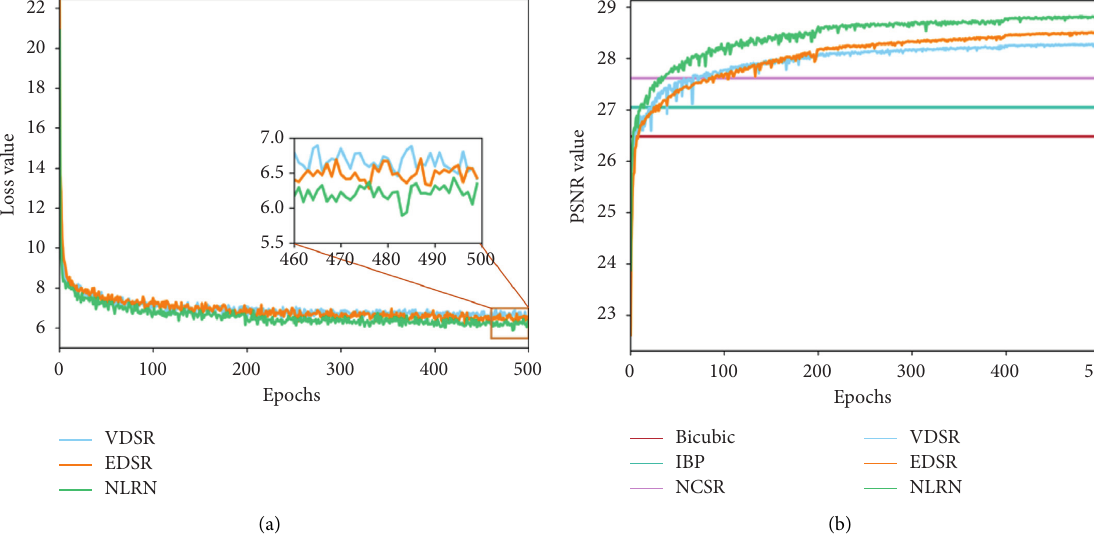
Figure 7: (a) Training l loss of VDSR, EDSR, and NLRN for scale × 4. (b) Validation PSNR values of Bicubic, IBP, NCSR, VDSR, EDSR, and 1 NLRN during training for scale × 2.